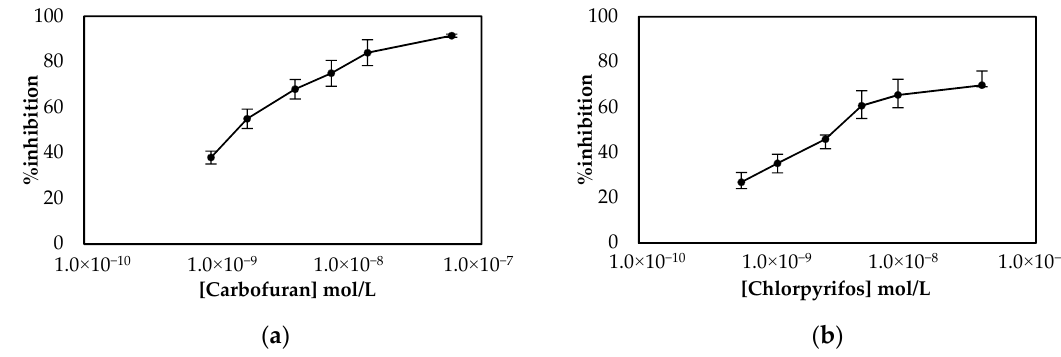
Figure 10. % Inhibition of AChE by a range of different concentrations of ( a ) carbofuran and ( b ) chlorpyrifos in pretreated spiked olive oil samples. The measurements were carried out in triplicate with LIFT-spotted fCB/CS/AChE modified electrodes.